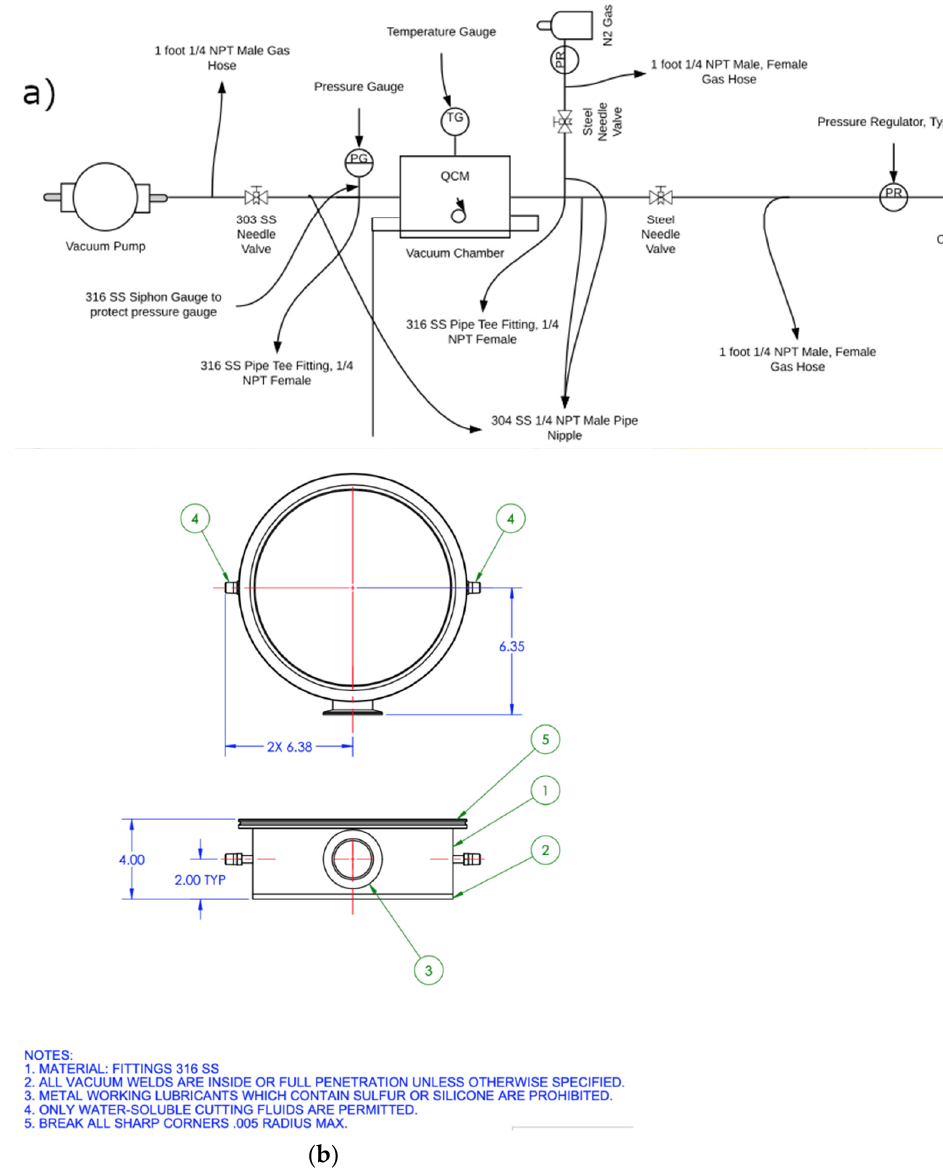
Figure 2. Quartz crystal microbalance assembly for testing CO 2 sorption ( a ) full system schematic and ( b ) stainless steel vacuum chamber dimensions (Nor Cal Products Inc., Siskiyou County, CA, USA).